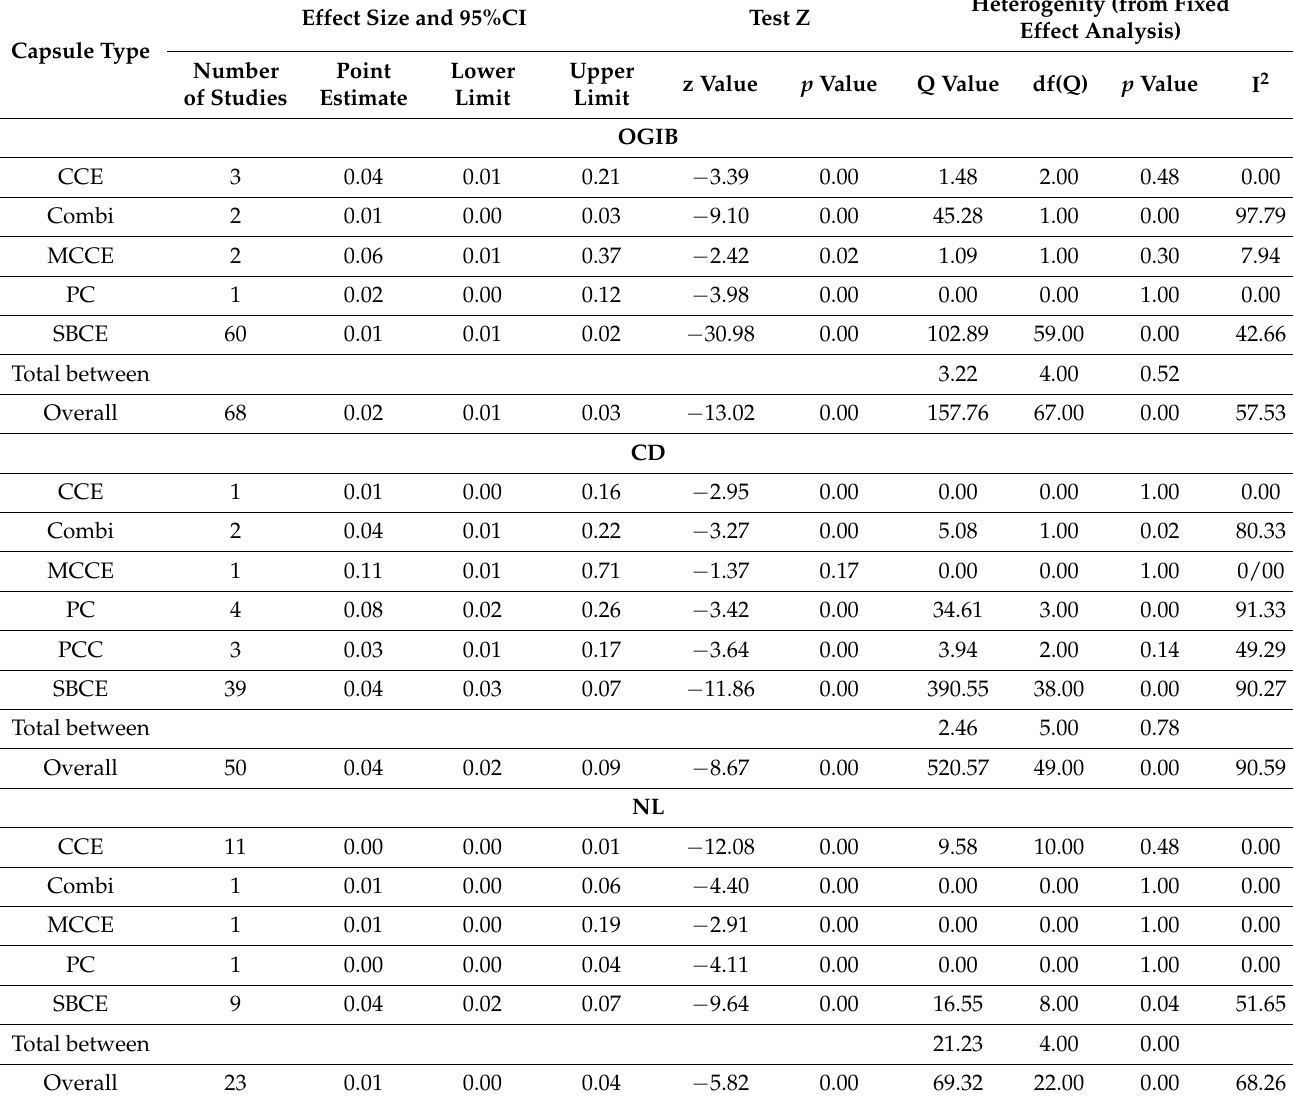
Table 3. Retention rates by type of capsule